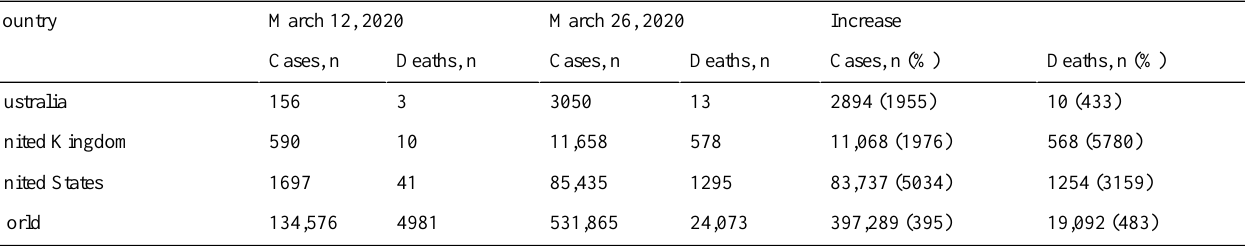
Table 1. Coronavirus disease cases and deaths worldwide in Australia, the United Kingdom, and the United States from March 12 to 16,